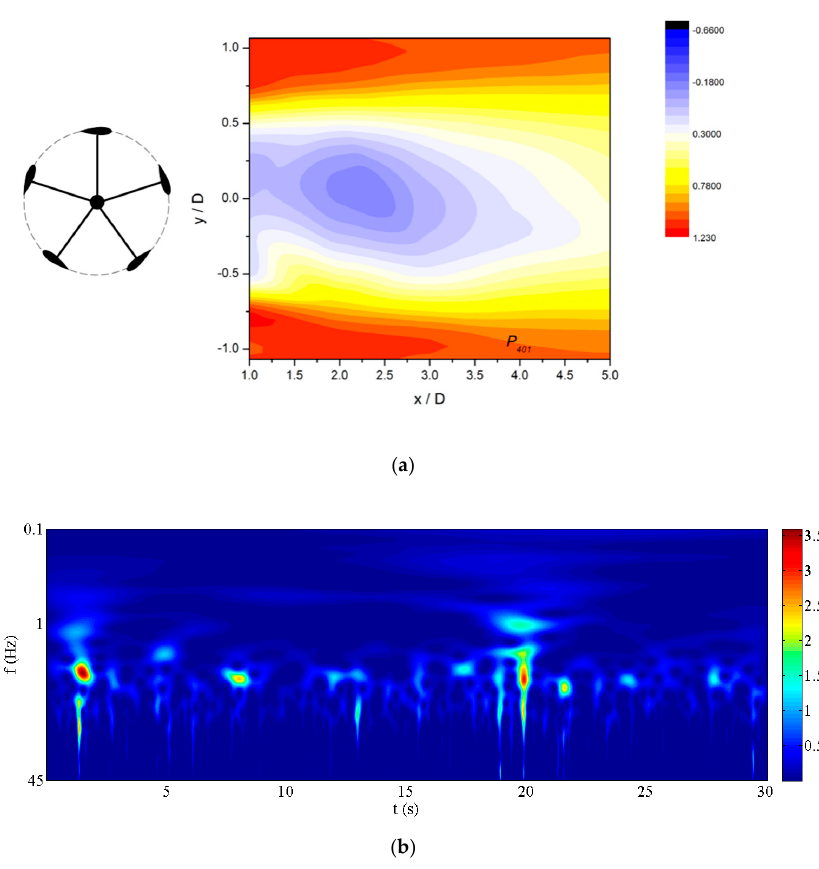
Figure 10. The wavelet spectrum of the time series signal of the streamwise fluctuating velocity at P 401 of the turbine wake with configuration E, n = 5, c = 64.8 mm: ( a ) schematic diagram, ( b ) P 401 . At P 401 of the turbine wake with configuration E (Figure 10b), no evident dominant frequency energy band can be observed. Thus, the wind turbine wake with configuration E does not transform into a bluff body wake mode.